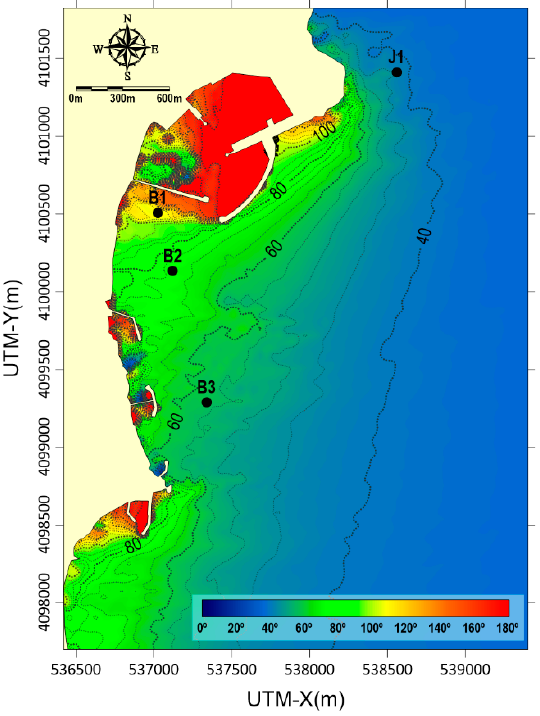
Figure 8. Distribution of the wave propagating direction, D m , modeled by TELEMAC–TOMAWAC, Case 1. Table 2. List of the wave parameters calculated from the model results, Case 1. The percentages in the parenthesis are the model errors from the observations.